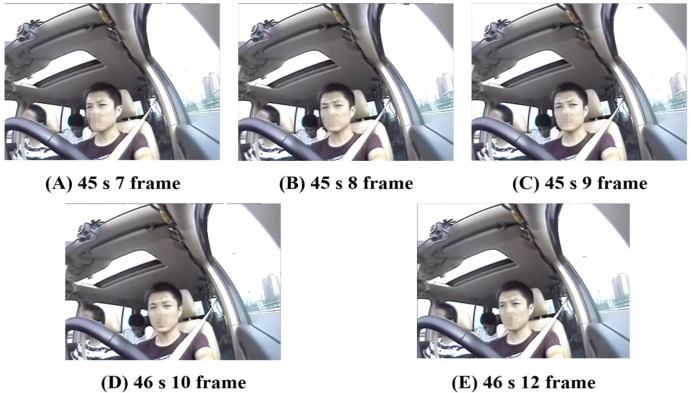
Driver distraction.